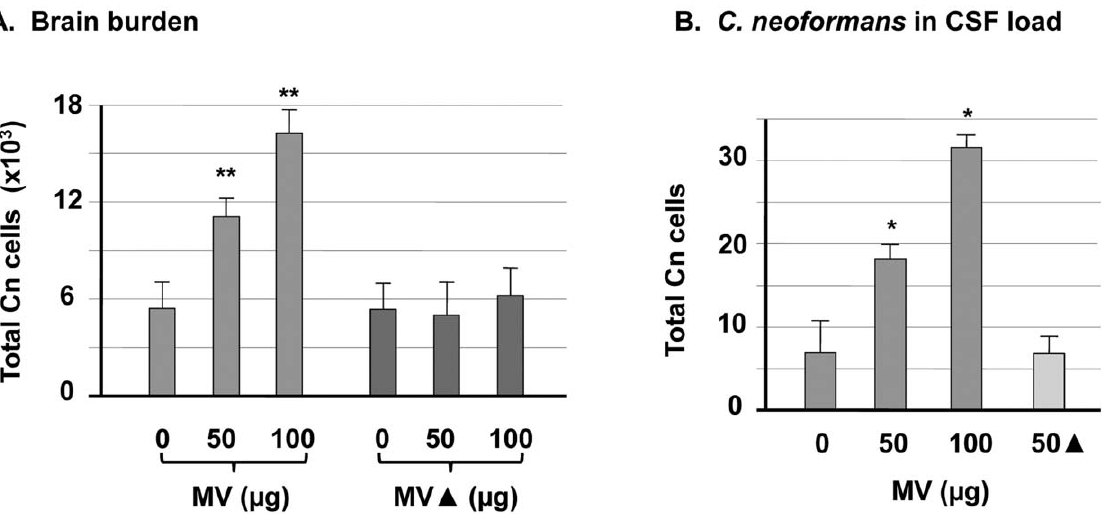
Figure 6. CnMVs enhanced C.neoformans brain infection. ( A ) Groups of 3-5 C57LB/6 mice were intravenously injected with 50–100 m g purified MVs or MV m (MVs heat-treated at 95 u C for 10 min) and 10 6 B-4500FO2 C. neoformans cells. The brains were harvested 24 hours after the injection. Quantitative cultures were performed by plating the brain homogenates on YPD medium (n=4) (P , 0.01). ( B ) The same approach as in (A) was followed except that the C. neoformans cells were collected from the CSF (n=3). Data, expressed as CFU, were the means 6 SD of plates inoculated in triplicate from three independent experiments (P , 0.05).